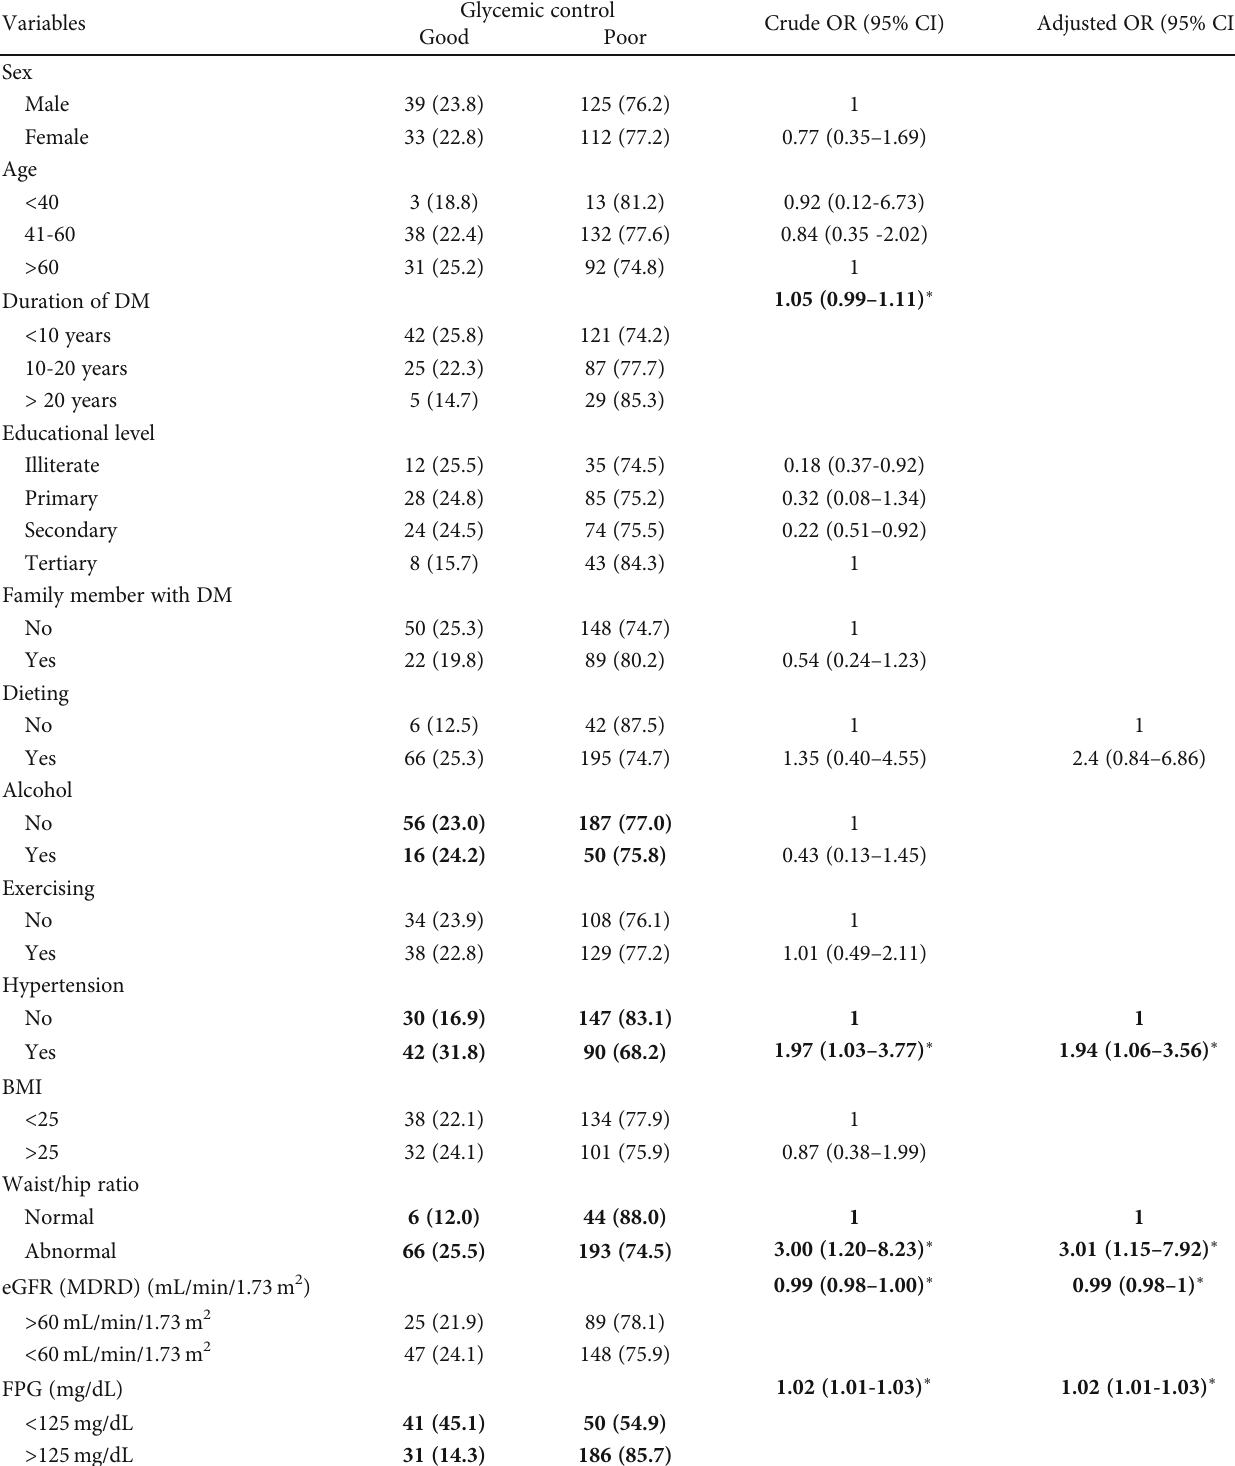
Table 2: Bivariate and multivariable logistic regression analyses of factors associated with poor glycemic control in DM patients at Halibet Regional Referral Hospital, in Asmara, Eritrea ( n = 309